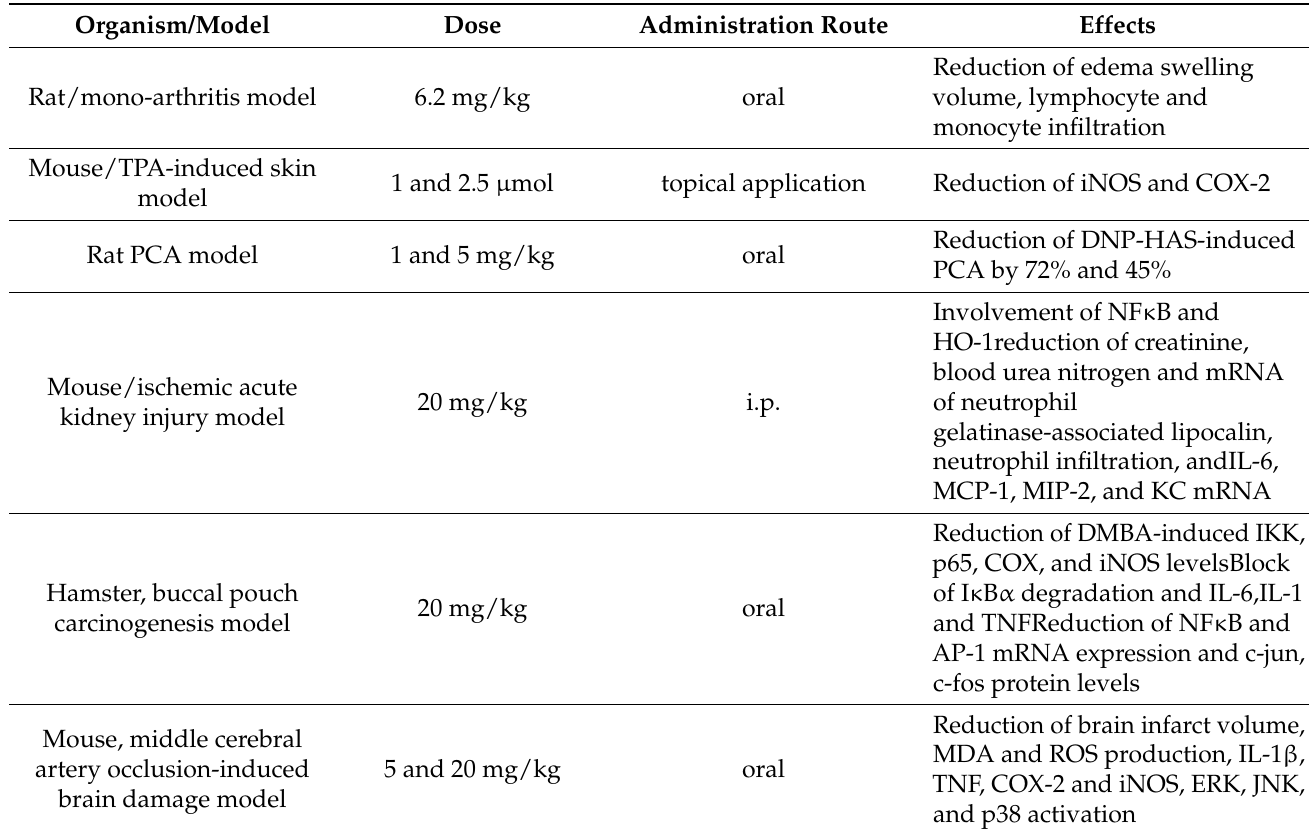
Table 2. In vivo anti-inflammatory effects of